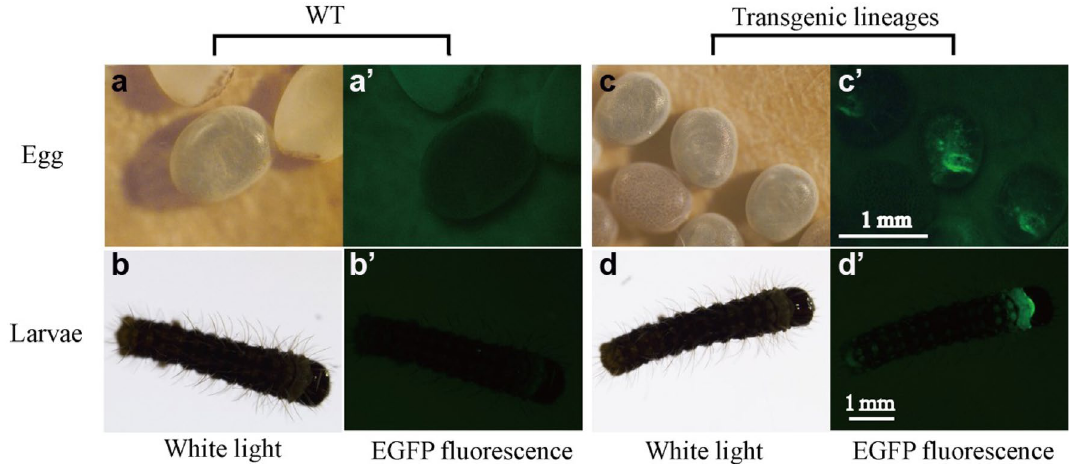
Figure 2. Positive transgenic strains for EGFP-specific expression in the G1 stage. ( a , a ′ ) G1 eggs and ( b , b ′ ) larvae of the WT strains were viewed under white light and EGFP fluorescence microscopy, respectively; ( c , c ′ ) G1 eggs and ( d , d ′ ) larvae of the positive strains were viewed under white light and EGFP fluorescence microscopy, respectively. The phenotypes of these two transgenic strains were similar under green fluorescence